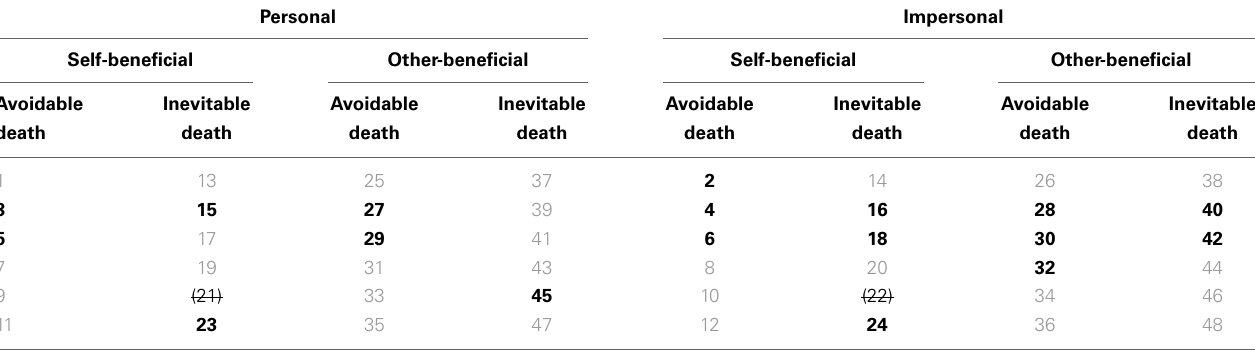
Table 1 | Revised dilemmas.